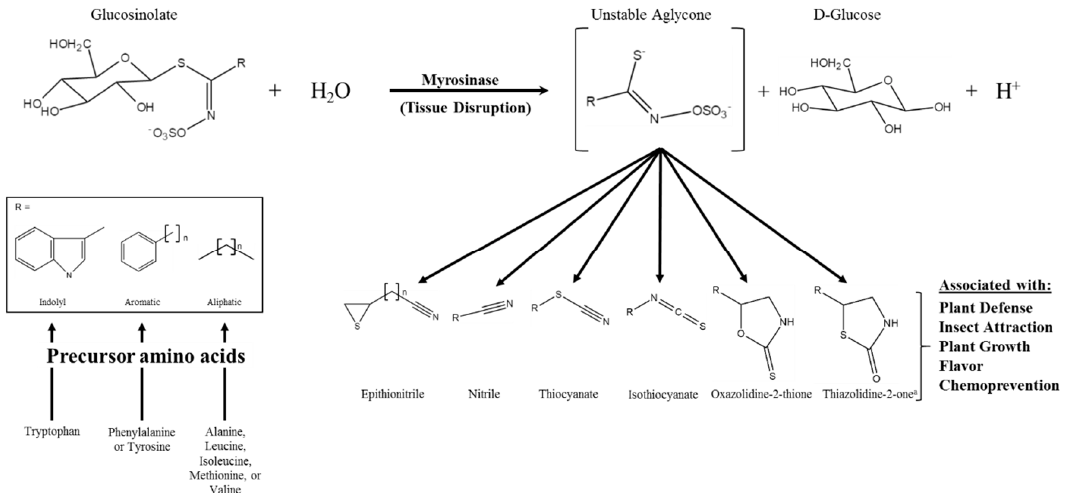
Figure 1. Glucosinolate hydrolysis by myrosinase, possible hydrolysis products, and the various bioactivities associated with those products; modifed from [12,19]. The generic glucosinolate side chain structures (R) can undergo further modifications at virtually every position. a Novel hydrolysis product structure recently described in [20] .